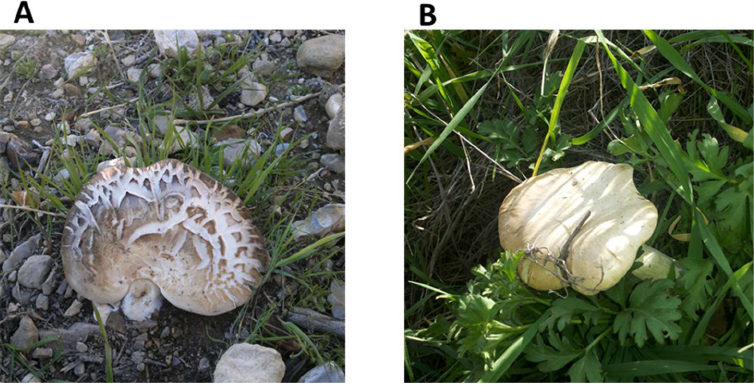
Figure 1. Pleurotus isolates collected from two different natural habitats across Jordan. ( A ) Tell ar-Rumman; ( B ) Um-Qais.